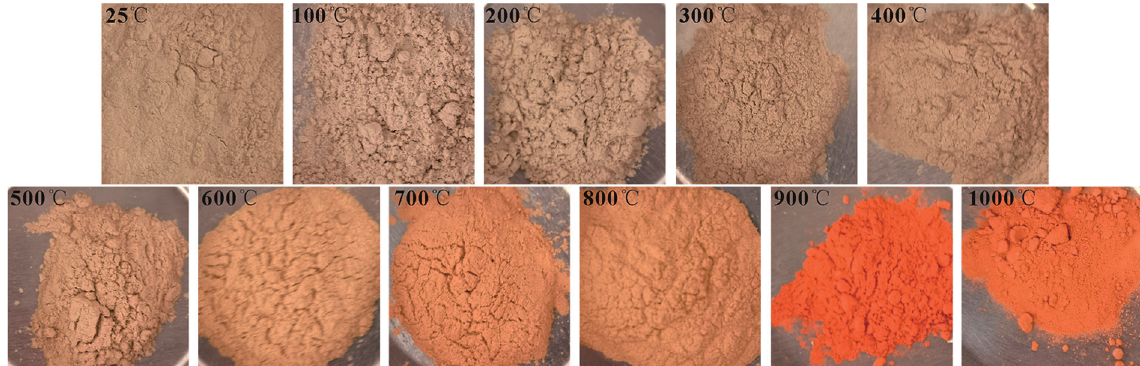
Figure 1: Na-montmorillonite and its thermal treatment products.